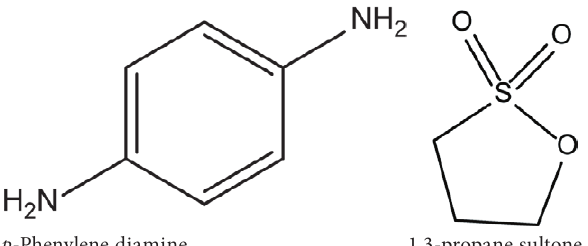
Figure 1. Chemical structures of the monomers used to produce: